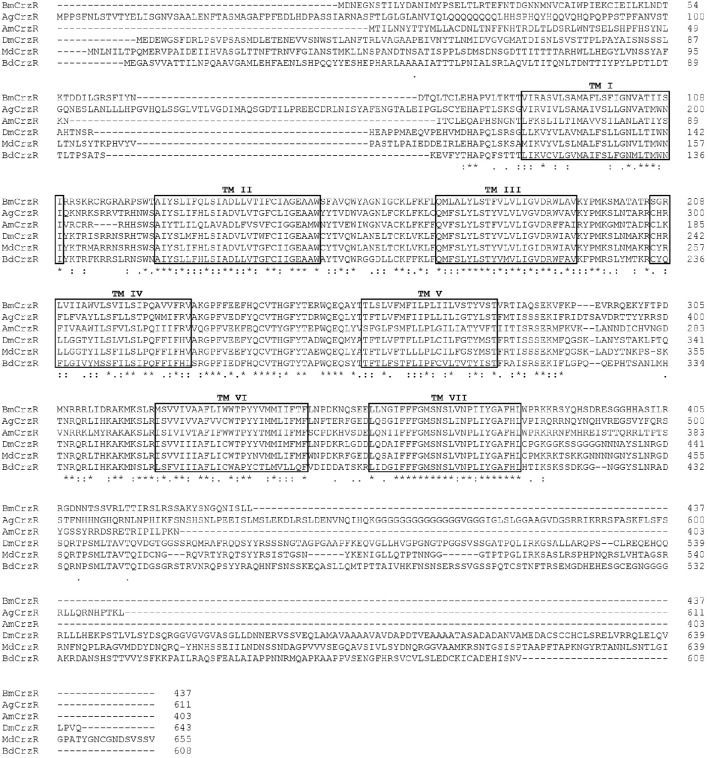
Amino acid sequence alignment of the BdCrzR with other related GPCRs. Conservative aa are indicated by asterisks. Seven transmembrane domains are highlighted in black box (TM I–TM VII). The corazonin receptor of Bombyx mori (BmCrzR), Anopheles gambiae (AgCrzR), Apis mellifera (AgCrzR), Drosophila melanogaster (DmCrzR), and Musca domestica (MdCrzR) were used for alignment.